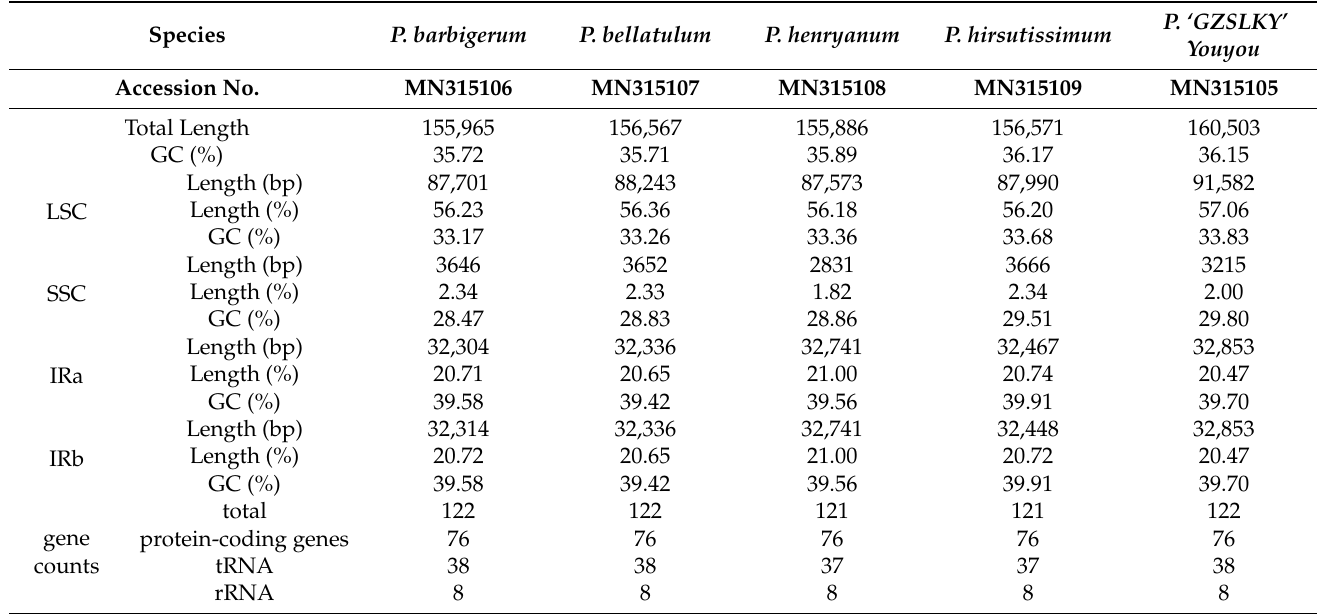
Table 1. The chloroplast genomic features of the five Paphiopedilum species newly assembled in this